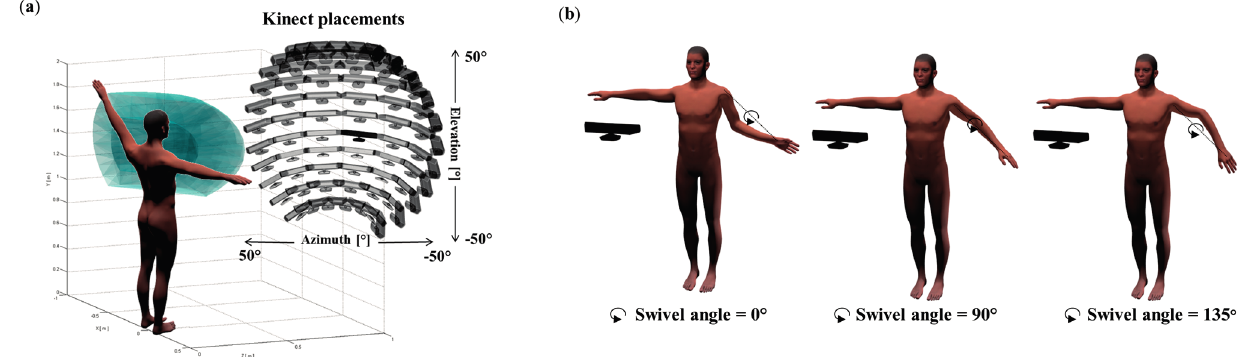
Figure 2. ( a ) Parameters of the experimental setup, the left hand reaching volume in blue (azimuth, elevation and elbow flexion) and the positions and orientations of the sensor in dark (azimuth and elevation); ( b ) The type of grip parameter: Grip from below at the left (0° swivel angle), grip from the side at the middle (90° swivel angle) and grip form above at the right (135° swivel